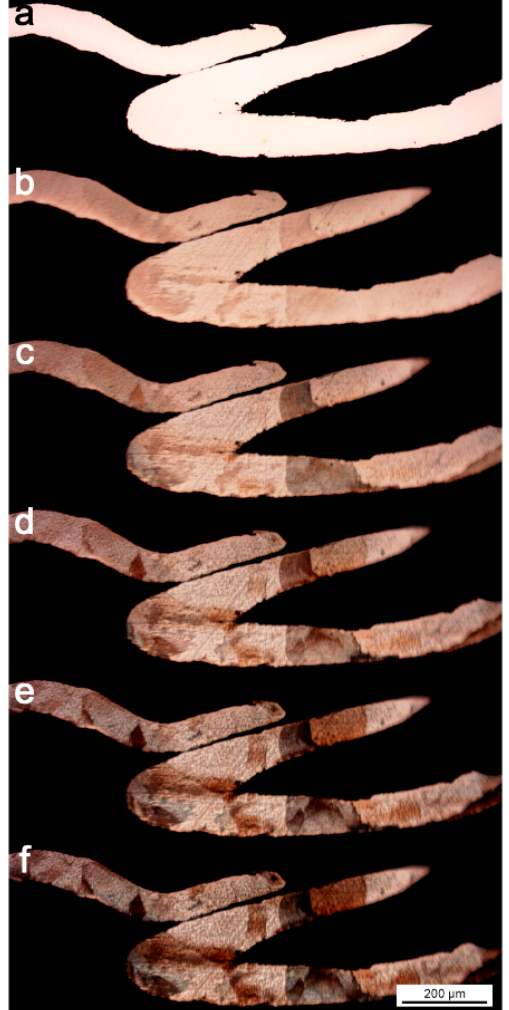
Figure 1. The ancient gold sample (of the gold artifact from the Sanxingdui site) was etched by diluted aqua regia (6 mL HCl + 2 mL HNO 3 and diluted to 20 mL); ( a – f ) show the morphology of the sample from etching for 0 s to 100 s, respectively (20 s